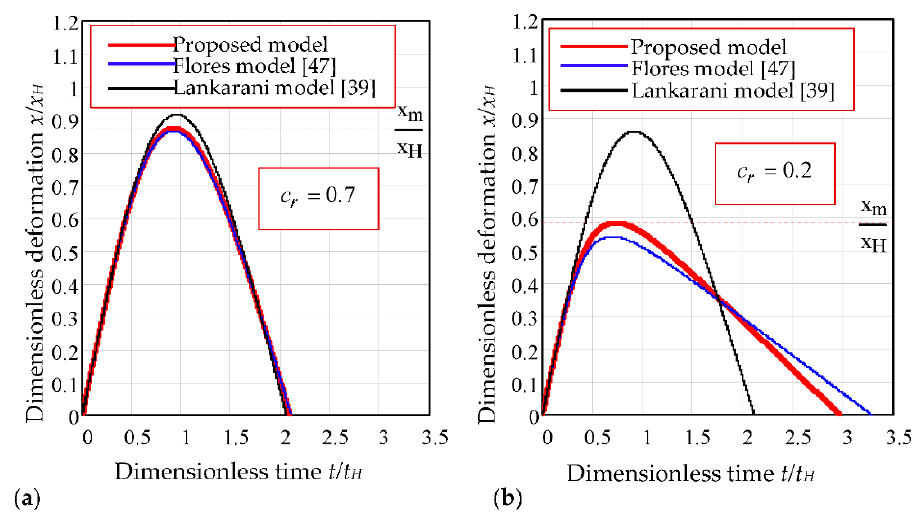
Figure 17. Normal approach versus time for the three models: ( a ) 𝑐 (cid:3045) = 0.7 and ( b ) 𝑐 (cid:3045) = 0.2 .